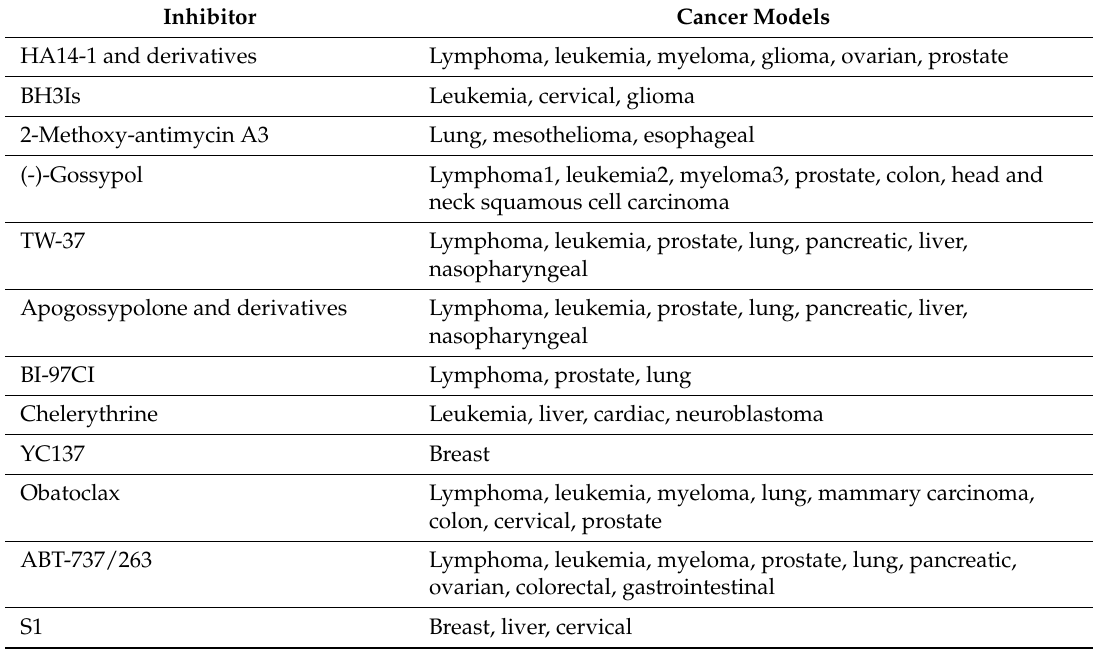
Table 7. Preclinical activities of BH3 mimetics